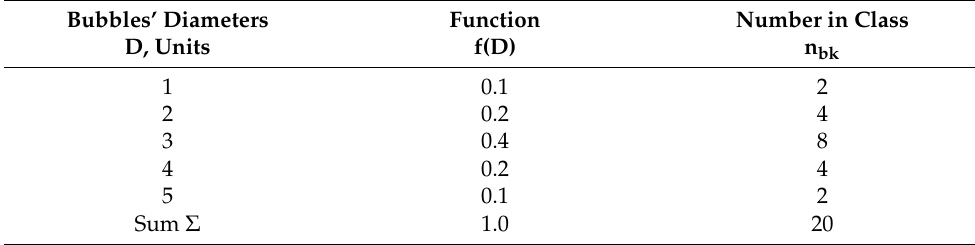
Table 2. Distribution of bubbles’ diameters (an example).